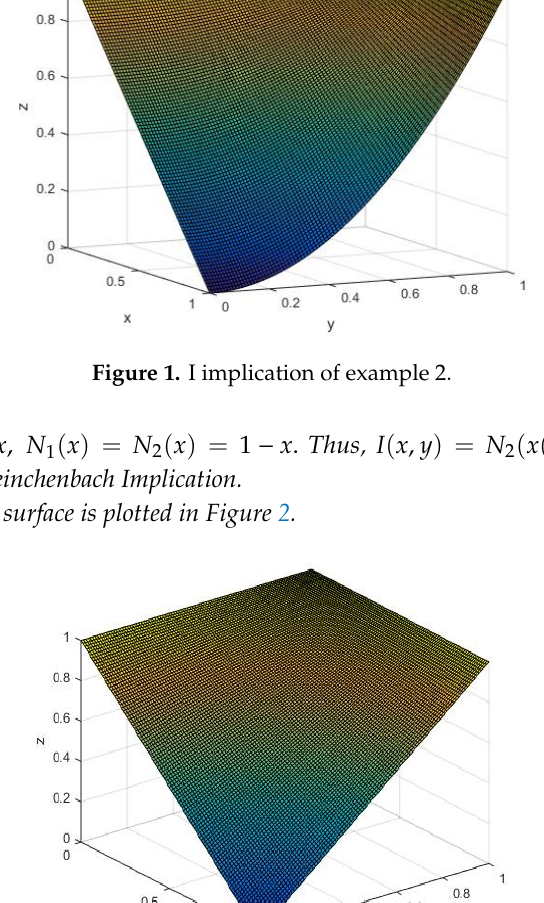
Figure 3. I implication of example 4.